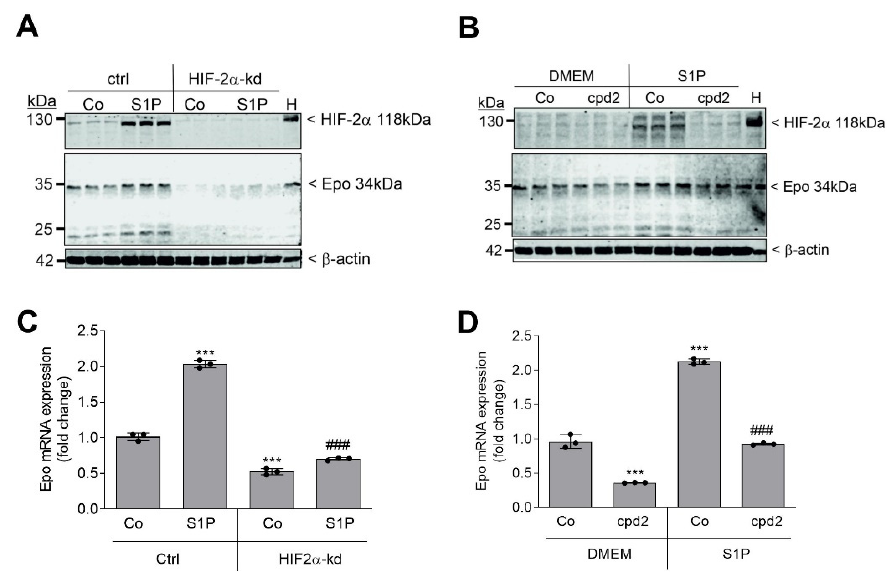
Figure 2. Effect of HIF-2 α knockdown and an HIF-2 α inhibitor on S1P-stimulated Epo protein and mRNA expression in F3-5 cells. ( A , C ) Confluent Ctrl or HIF-2 α knockdown (kd) cells were serum-starved for 16 h prior to stimulation for further 6 h with either vehicle (Co) or S1P (500 nM). ( B , D ) Cells were pretreated for 30 min with the HIF-2 α inhibitor compound 2 (cpd2) at 10 µ M prior to stimulation for 6 h with vehicle (Co) or S1P (500 nM) in the presence of cpd2. As positive control, lysates of the neuroblastoma cell line Kelly, exposed for 16 h to 1% O 2 , were used (H). Thereafter, protein extracts ( A , B ) or RNA extracts ( C , D ) were prepared and proteins were separated by SDS-PAGE; transferred to nitrocellulose membranes; and subjected to Western blot analyses using antibodies against mouse Epo, HIF-2 α , or β -actin. RNA was taken for quantitative PCR analysis using primers of mouse Epo and mL28 for normalization. ∆∆ Ct values were calculated as fold increase compared with the untreated control and means ± S.D. ( n = 3), *** p < 0.001 was considered statistically significant when compared with the control samples. ### p < 0.001 compared with the S1P-stimulated control samples. Bands corresponding to Epo and β -actin were evaluated by Image Studio Lite software and the results are depicted in Supplementary Figure